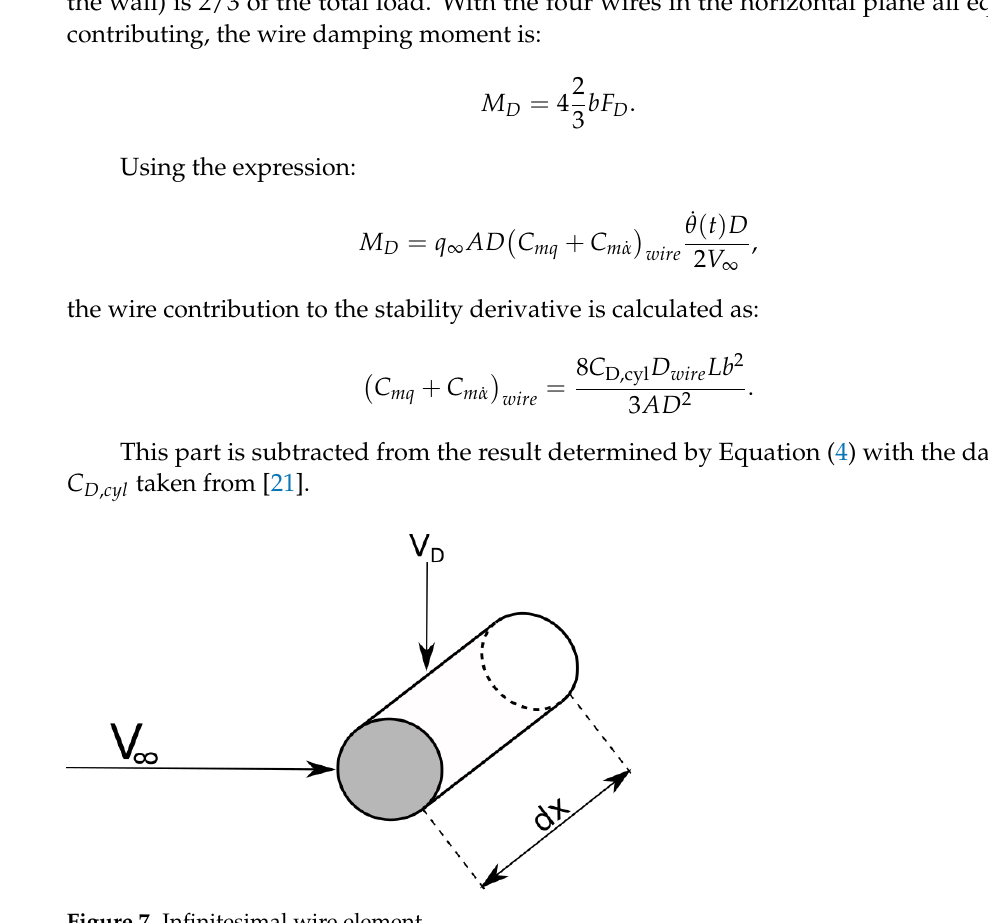
Figure 7. Infinitesimal wire